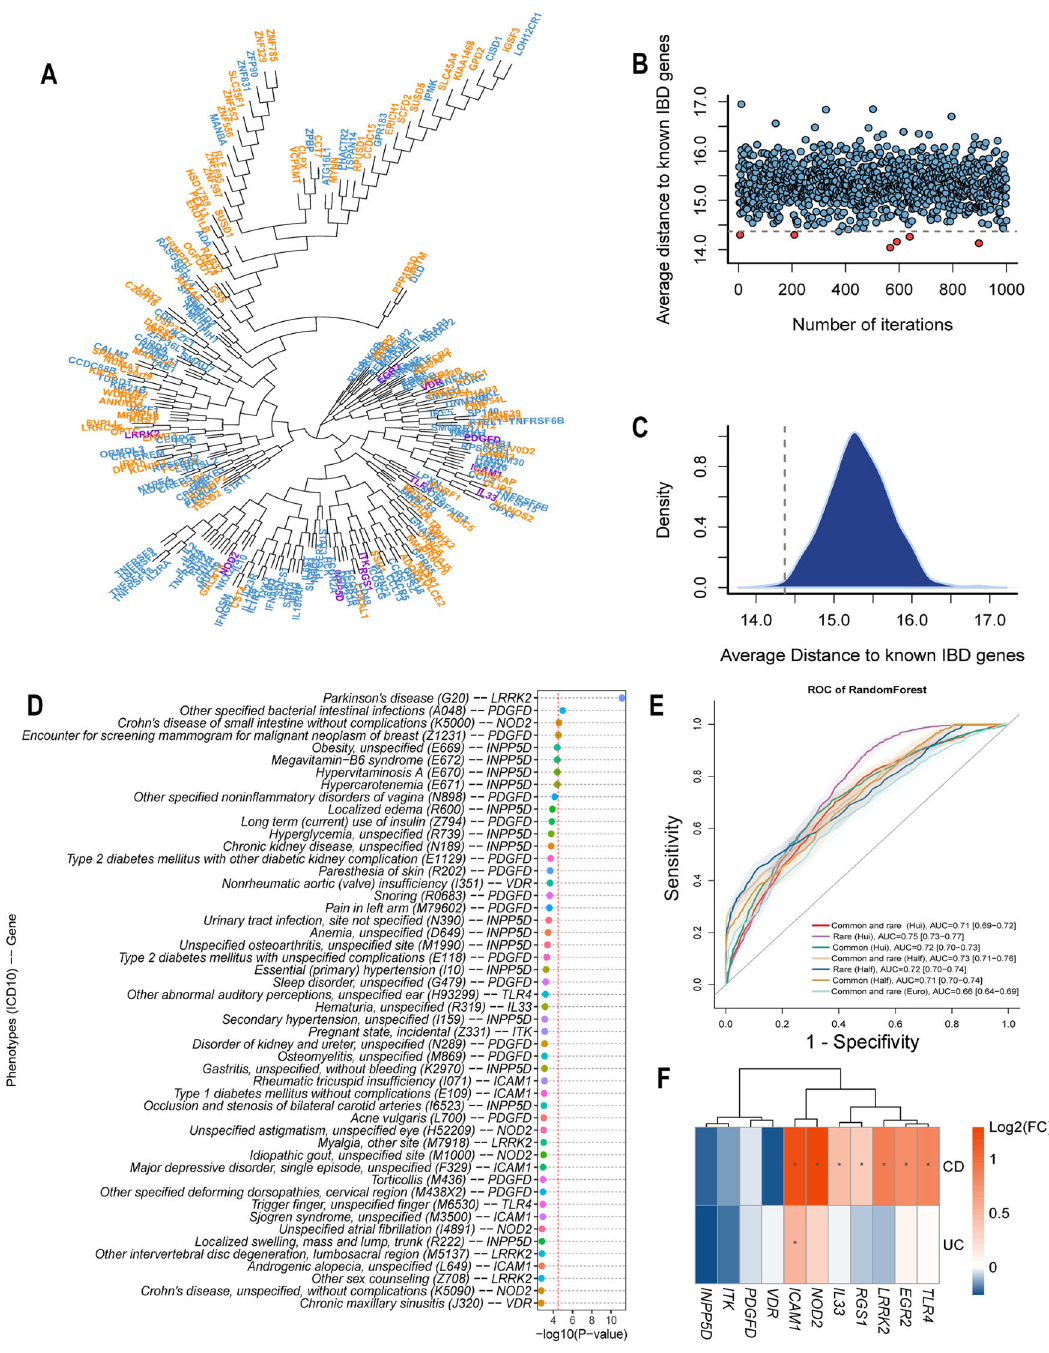
Fig. 3 | IBD candidate genes are biologically proximate to IBD known genes. Gene level PheWAS replicated IBD-associated genes in an independent cohort anddemonstratedthatIBDgenesarealsorelatedtootherimmuneresponses. A Clustering IBD candidate genes (blue) and IBD known genes (orange) according to biological relatedness by Functional Genomic Alignment function using the HGC.The11pathwayidenti fi edgenes(Fig.2A)areindicatedinviolet.Thecandidate genesdidnotformdistinctclusters;rather,theyweremixedwithIBDknowngenes. B A dot plot representing the average distance from a randomly selected gene set (127genes)toknownIBDgenes.Thegraydashedlinerepresentsthecutoffinterms of the average biological distance between IBD-associated genes and IBD known genes.Withgenesrandomlyresampled1000times,6randomgenesetshavelower average distances; hence, the empirical P value of our candidate genes being empirically associated with IBD as a group is 0.006. P value is unadjusted and the statisticaltestistwo-sided. C Adensityplotforallaveragedistancesinaresampling test;thepercentilesat2.5%and97.5%are14.27and14.48,respectively.Thevertical